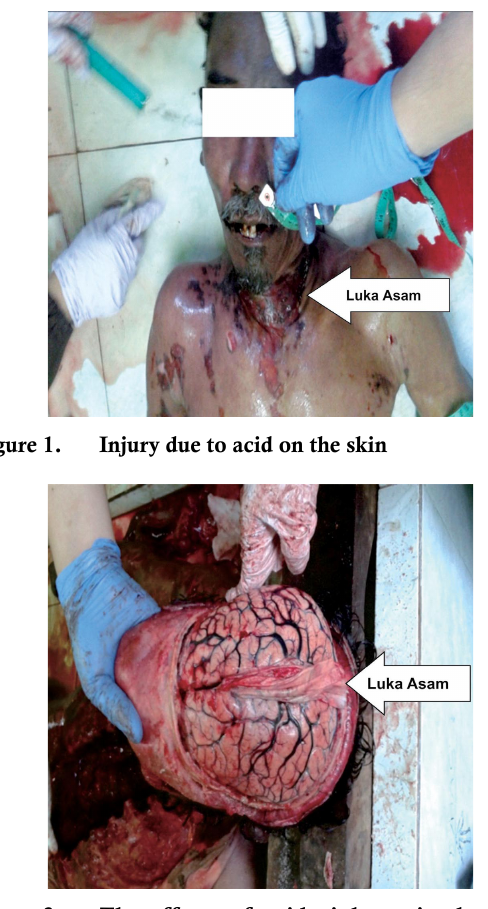
Figure . The effects of acid violence in the brain